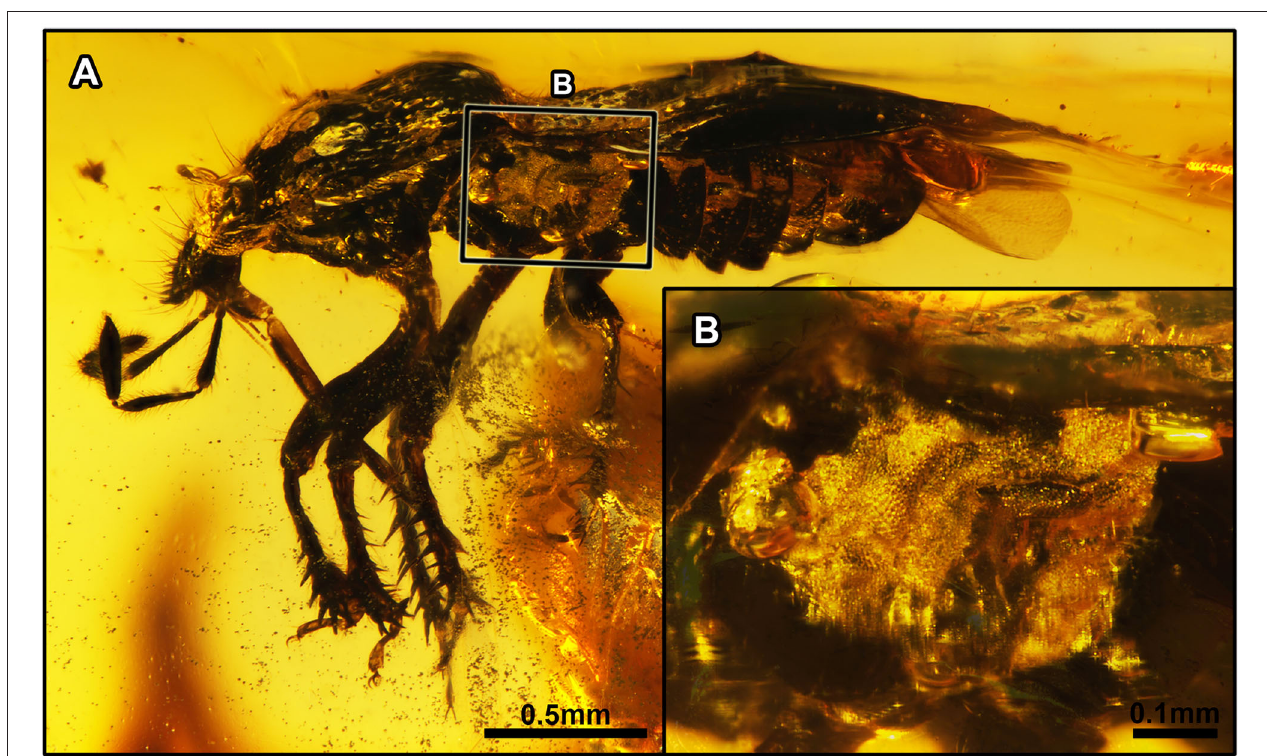
FIGURE 2 | Acanthamnestus atridorsus gen. et sp. nov., in Burmese amber. Holotype, CNU-HET-MA2019002 (male). (A) Habitus in left lateral view. (B) Detail of metathoracic scent gland, as located on (A) . Scale bars: A = 0.5mm; B =